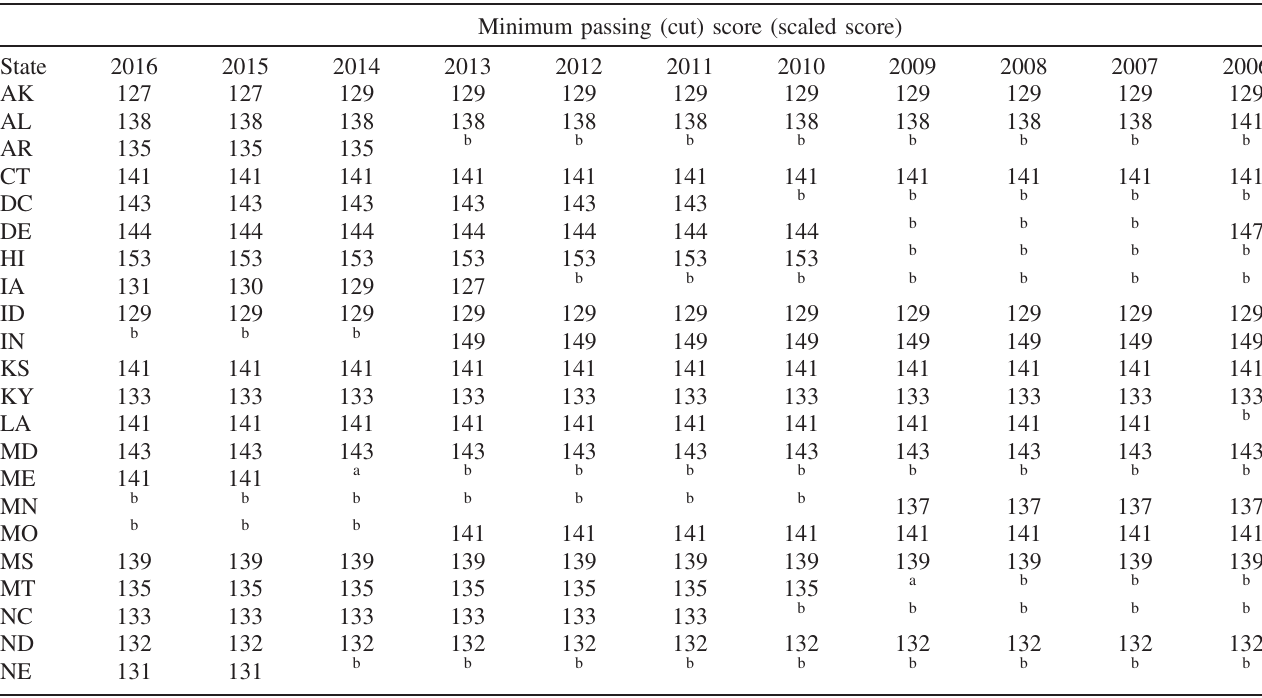
TABLE IV. Minimum passing scaled scores for 37 U.S. states and D.C. that have accepted the Praxis physics subject assessment from 2006 to 2016. Data was retrieved from annually published Praxis II series passing score by test and state documents from ETS [43 – 53]. Minimum passing (cut) score (scaled